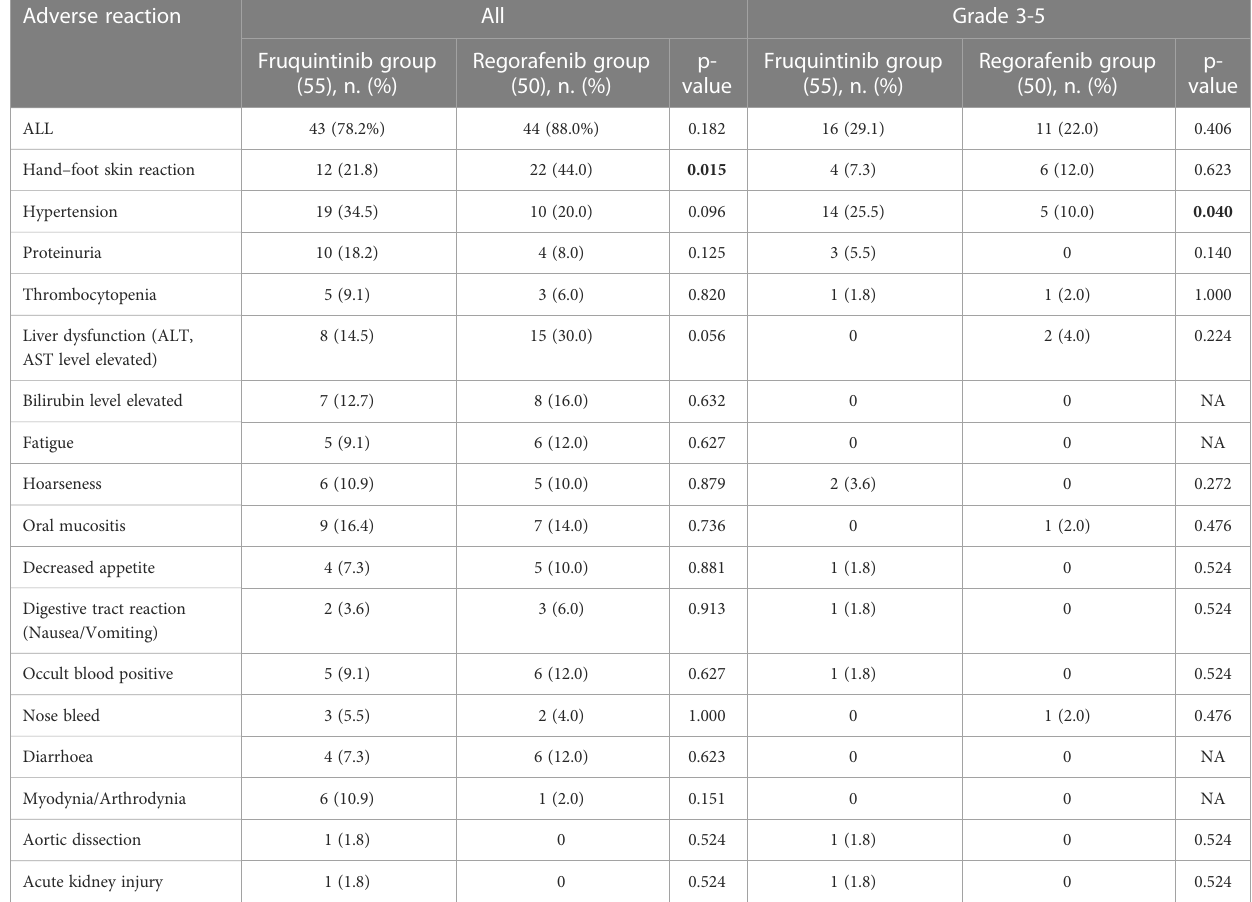
TABLE 3 Adverse